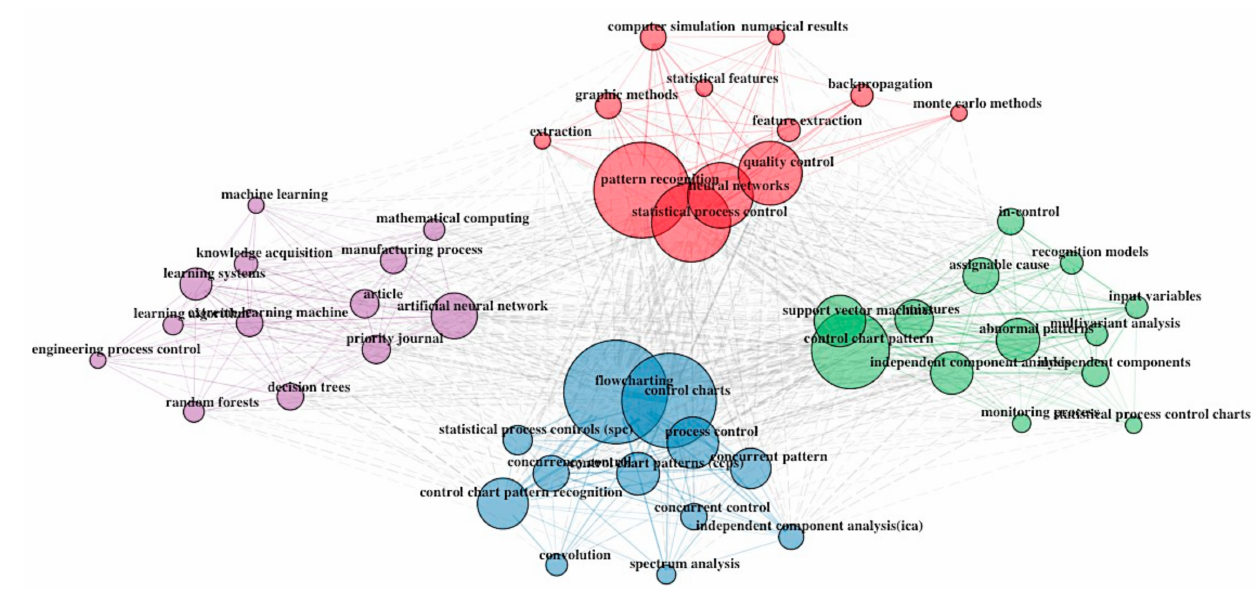
Figure 8. Network of authors’ keywords.